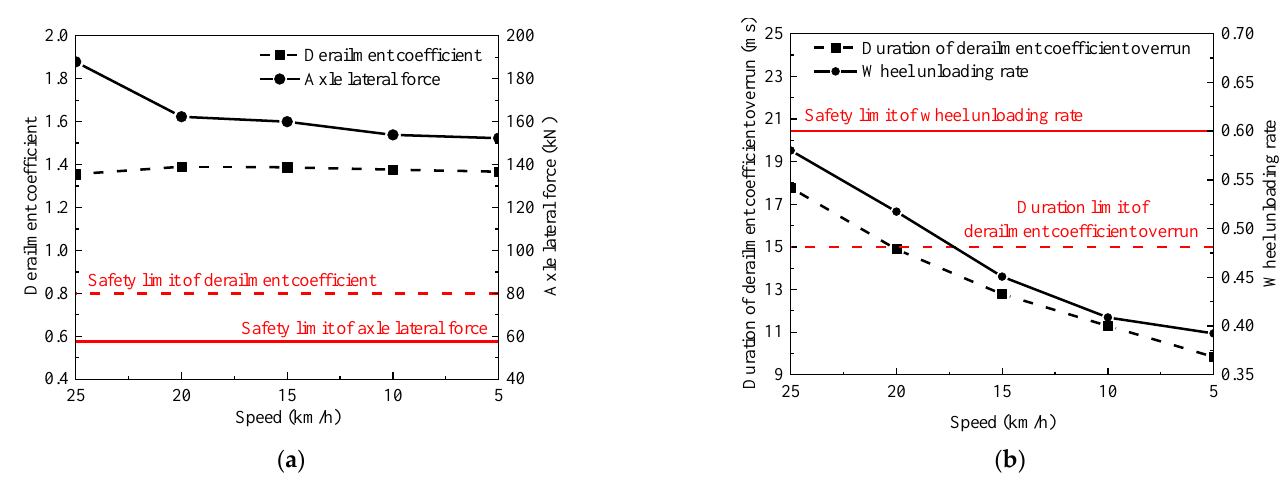
Figure 15. Operation safety indices vs. train running speed under conventional condictions: ( a ) de- railment coefficient and axle lateral force; ( b ) duration of derailment coefficient overrun and wheel unloading rate.